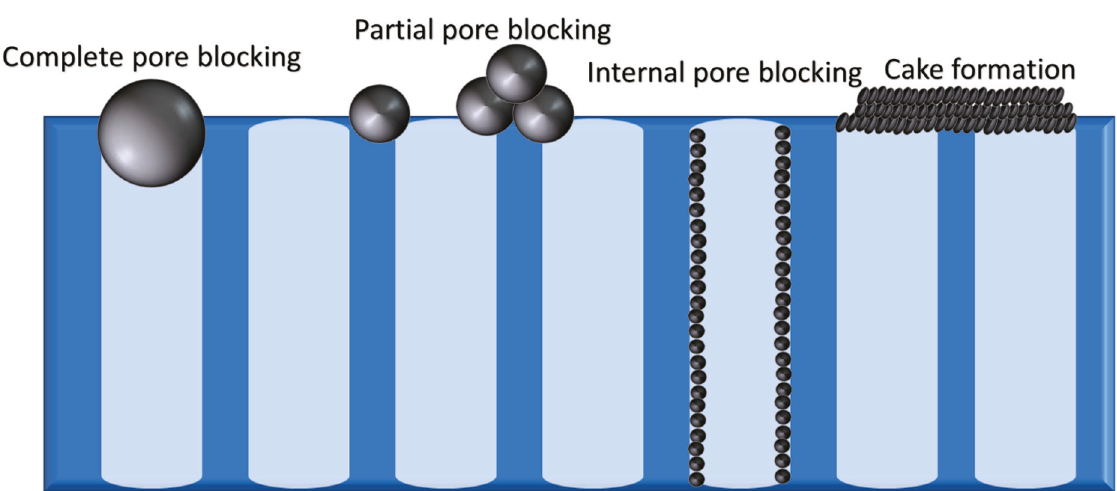
Figure 1. The four types of fouling (from left to right ) complete pore blocking, partial pore blocking, internal pore blocking, and cake formation.